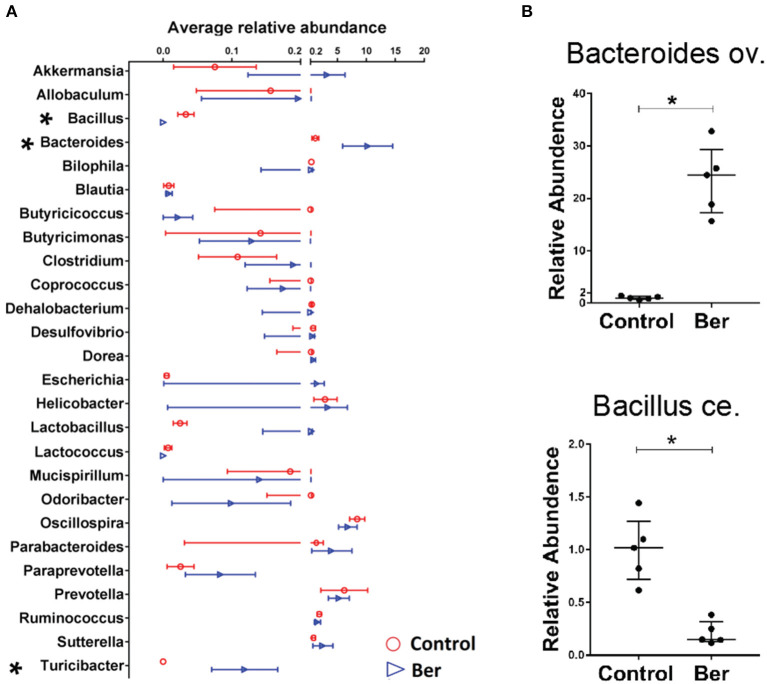
Berberine alters the composition of gut microbiota in recipient mice. Bacterial DNA was isolated from the cecum of B6 recipient mice transplanted with BALB/c islets 14 days after berberine treatment, and was analyzed via high-throughput sequencing. (A) The distribution of the top 26 bacterial taxa in berberine-treated and control groups at genus level (n = 4/group, shown as mean ± SEM, *P < 0.05). (B) Quantitative PCR was performed for validation of relative abundance of Bacteroides ov. and Bacillus ce. in caecum of control and berberine-treated mice (n = 5 mice/group, shown as median ± interquartile range with control group being set as 1.0).